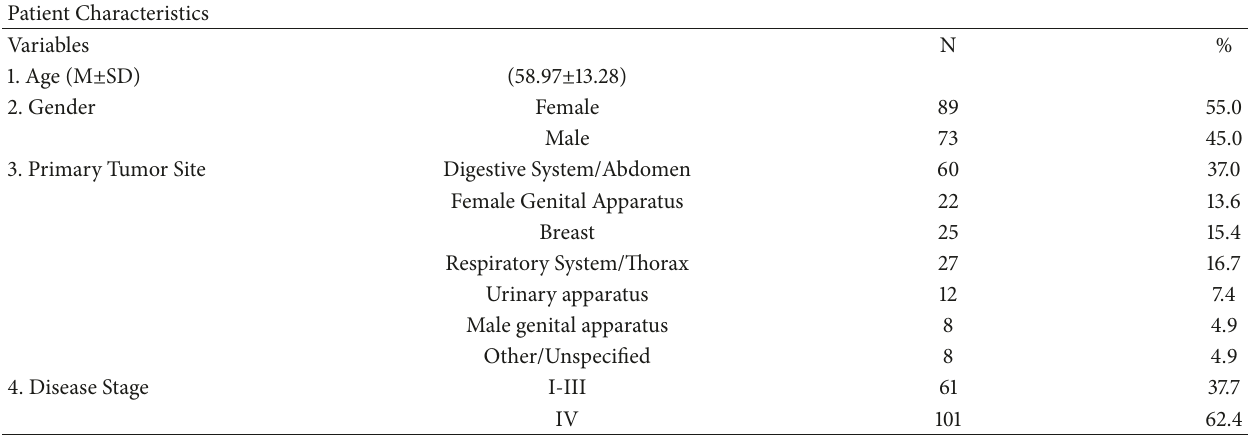
Table 1: Demographics and illness-related